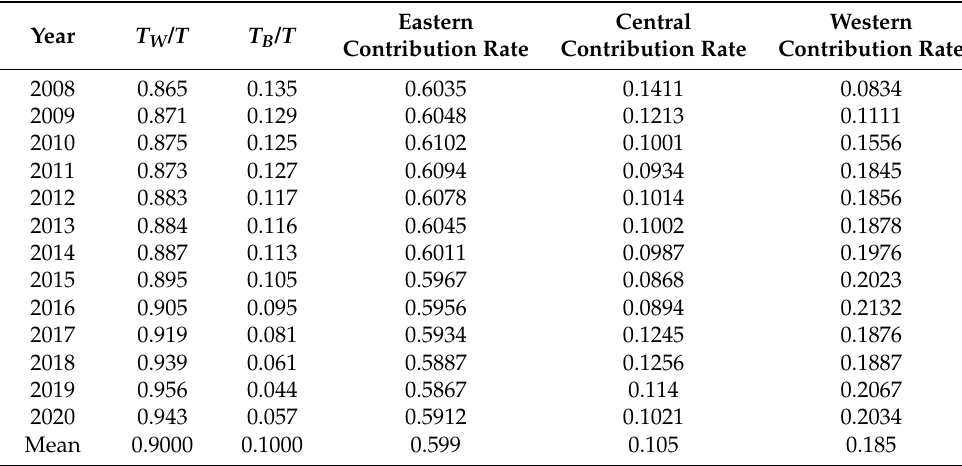
Table 7. Correlation measurement results. Energy Structure